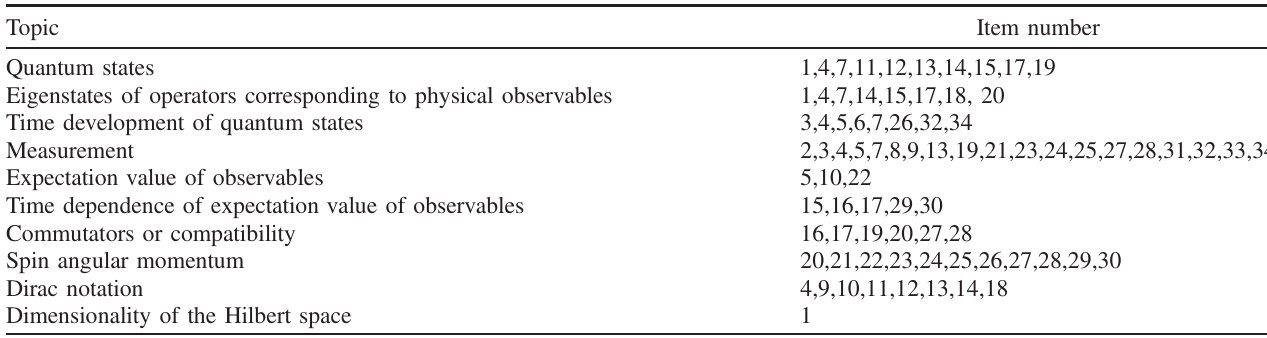
TABLE I. One possible categorization of the survey questions, the number of questions that fall in each category, and the question numbers belonging to each category. The number of questions in different categories do not add up to 34 because some questions fall into more than one